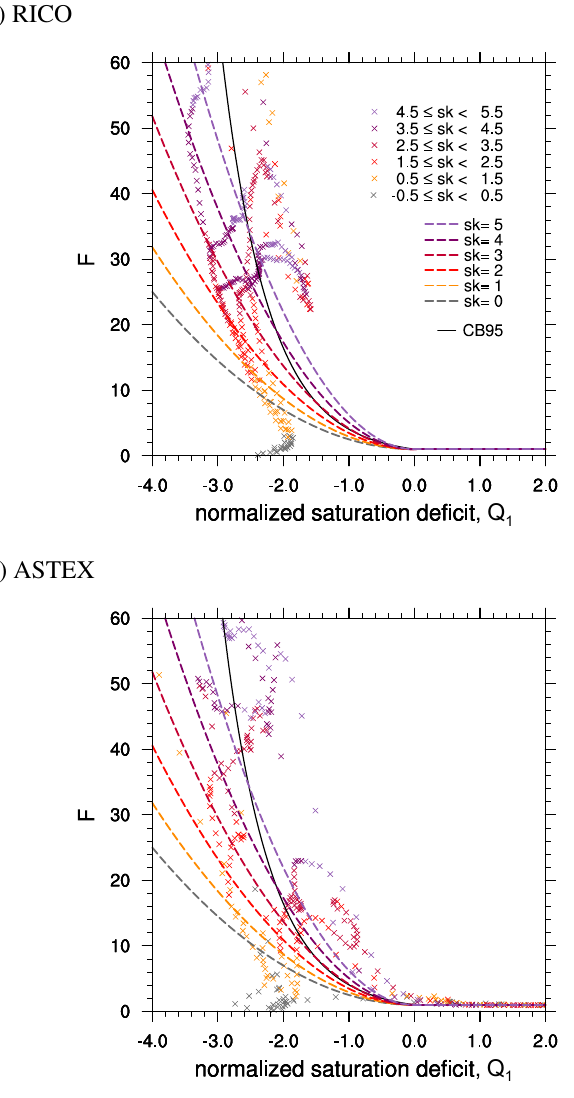
Fig. 5. New parameterization of F (dashed lines) as a function of the normalized saturation deficit and the skewness along with the parameterization of Cuijpers and Bechtold (1995, CB95) and the LES data (crosses).